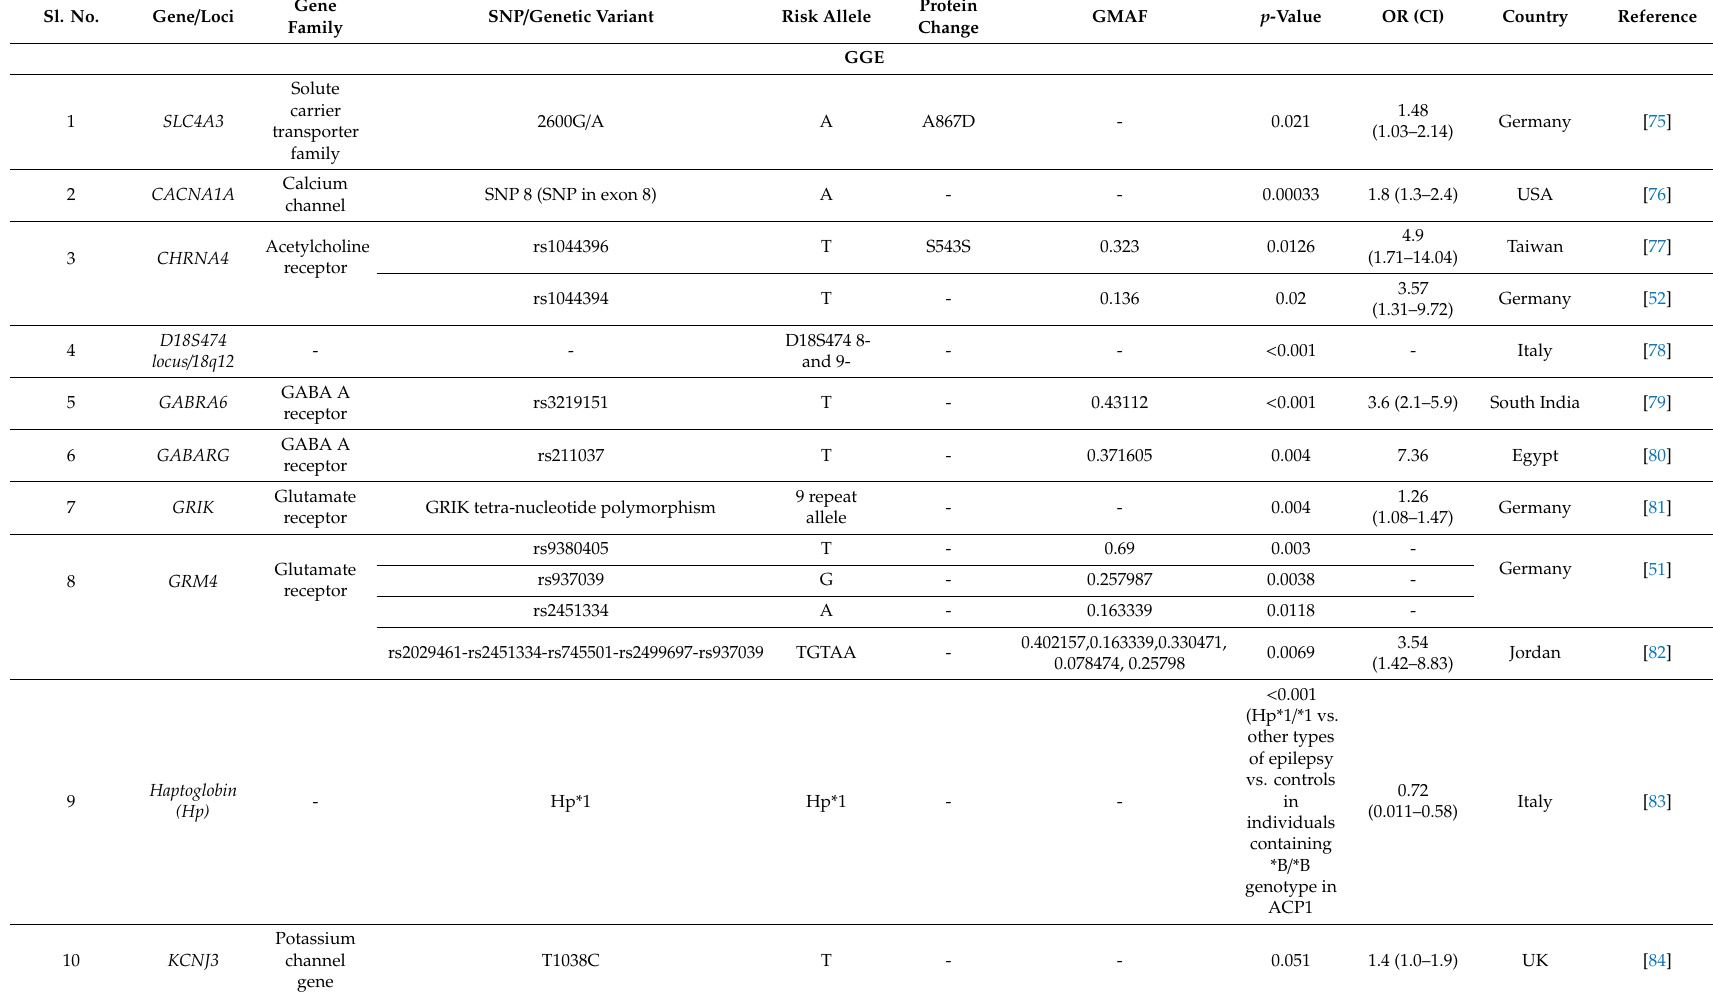
Table 1. Overview of the common epilepsyassociated genetic